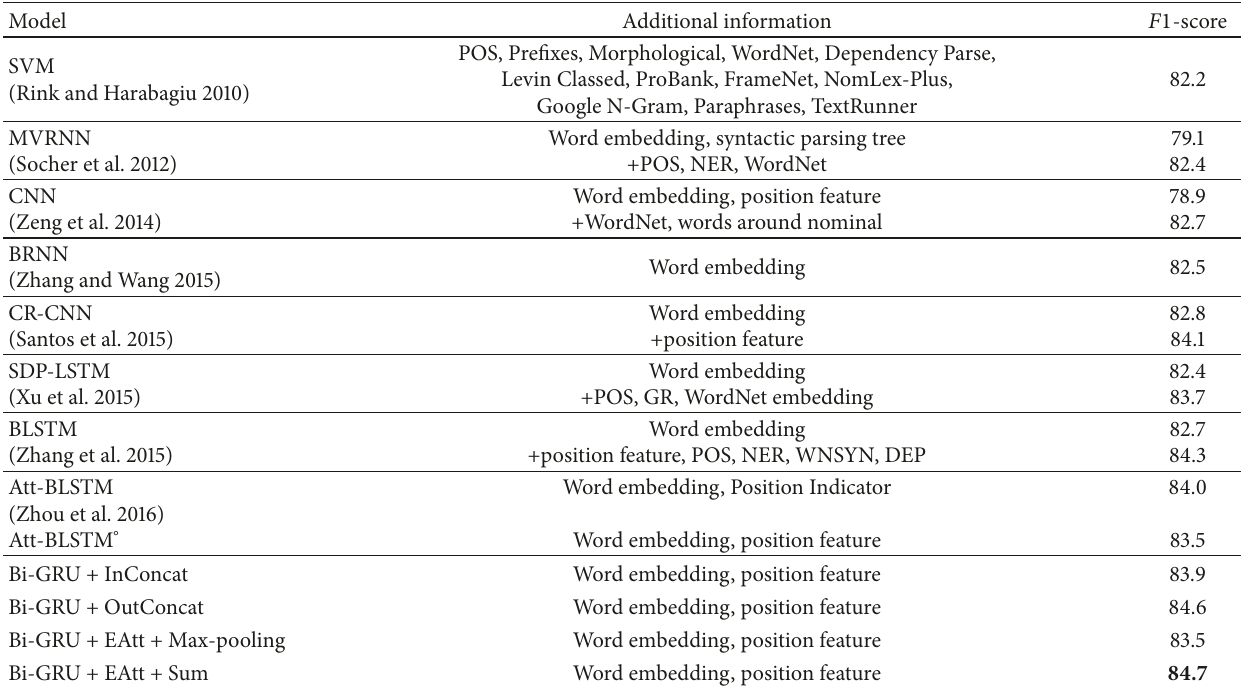
Table 2: Comparison with previous relation classification systems on SemEval-2010 Task 8 benchmark. Symbol “ ∘ ” means the experimental result is implemented by us. In the last line of the form, the performance of two strategies described in Section 3.4 is presented; they are represented as Max-pooling and Sum